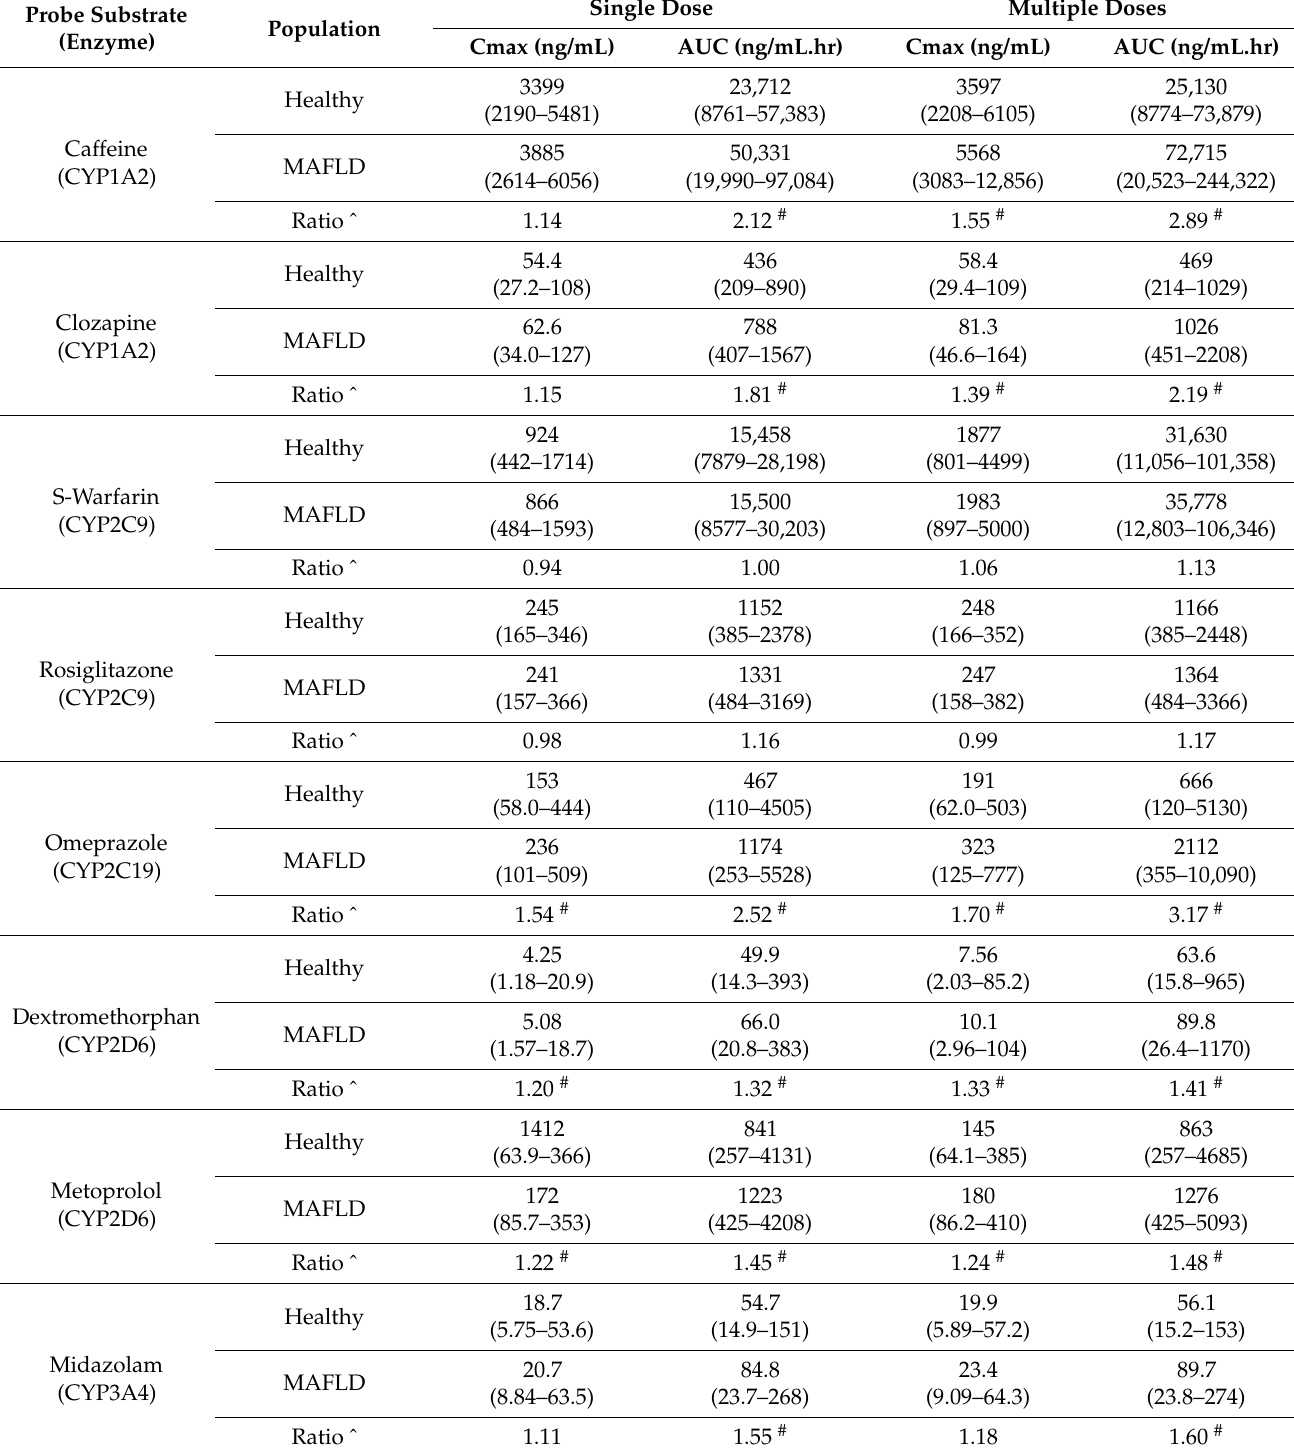
Table 1. Simulated geometric mean (95% CI) pharmacokinetic parameters defining probe substrate exposure in MAFLD and healthy control populations following single and multiple oral